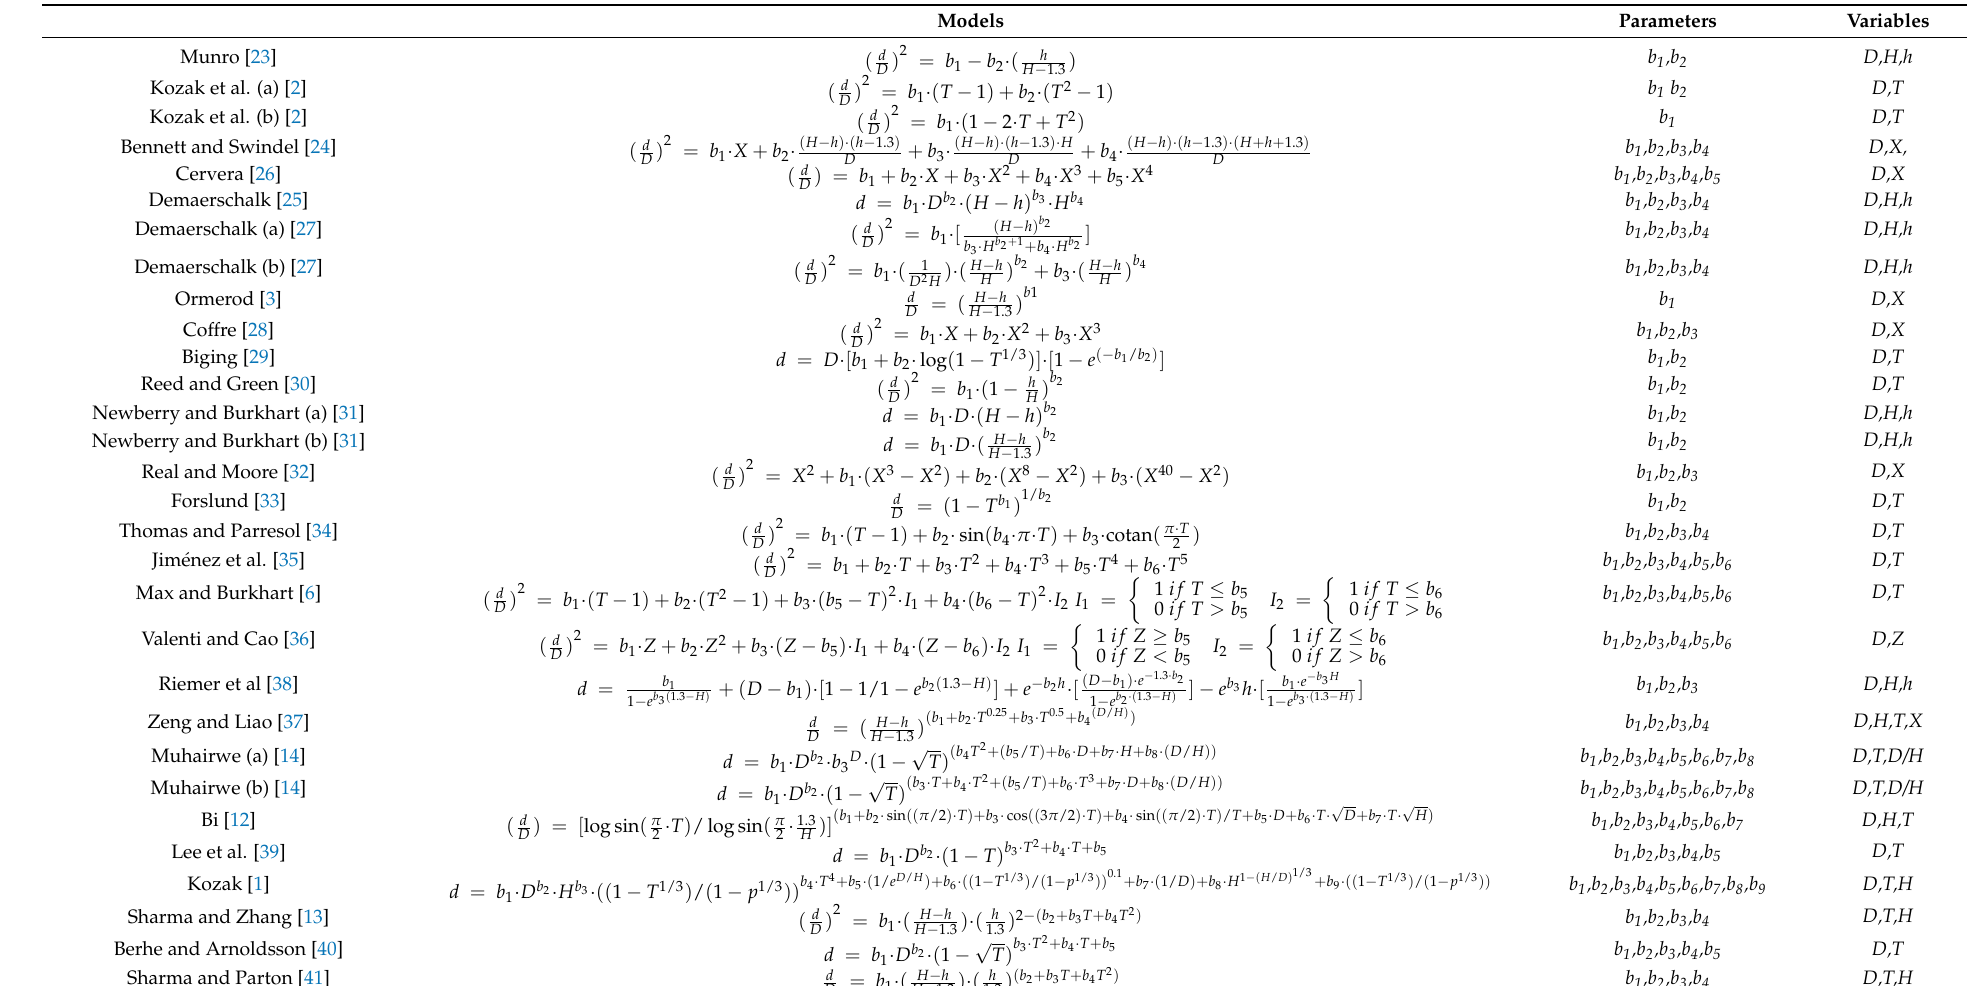
Table 2. Thirty stem taper equation selected as candidate